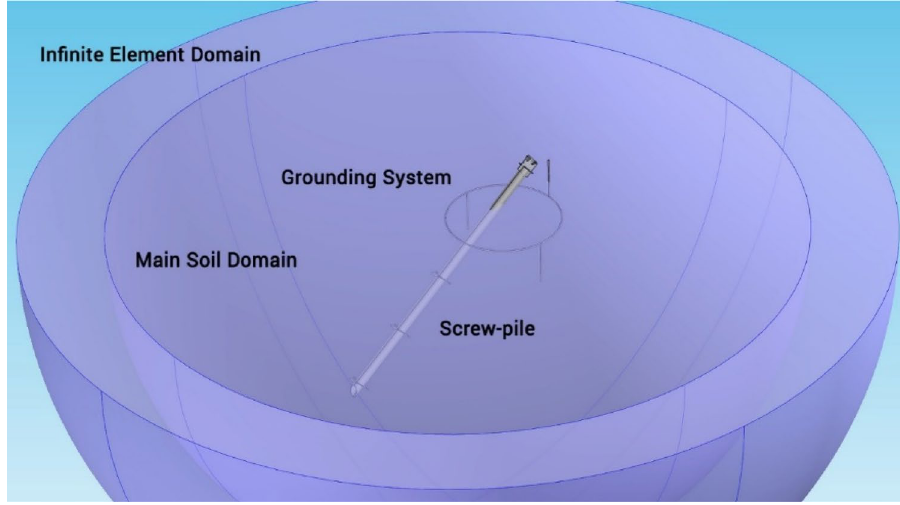
Figure 1. Three-dimensional geometry model for the considered screw-pile